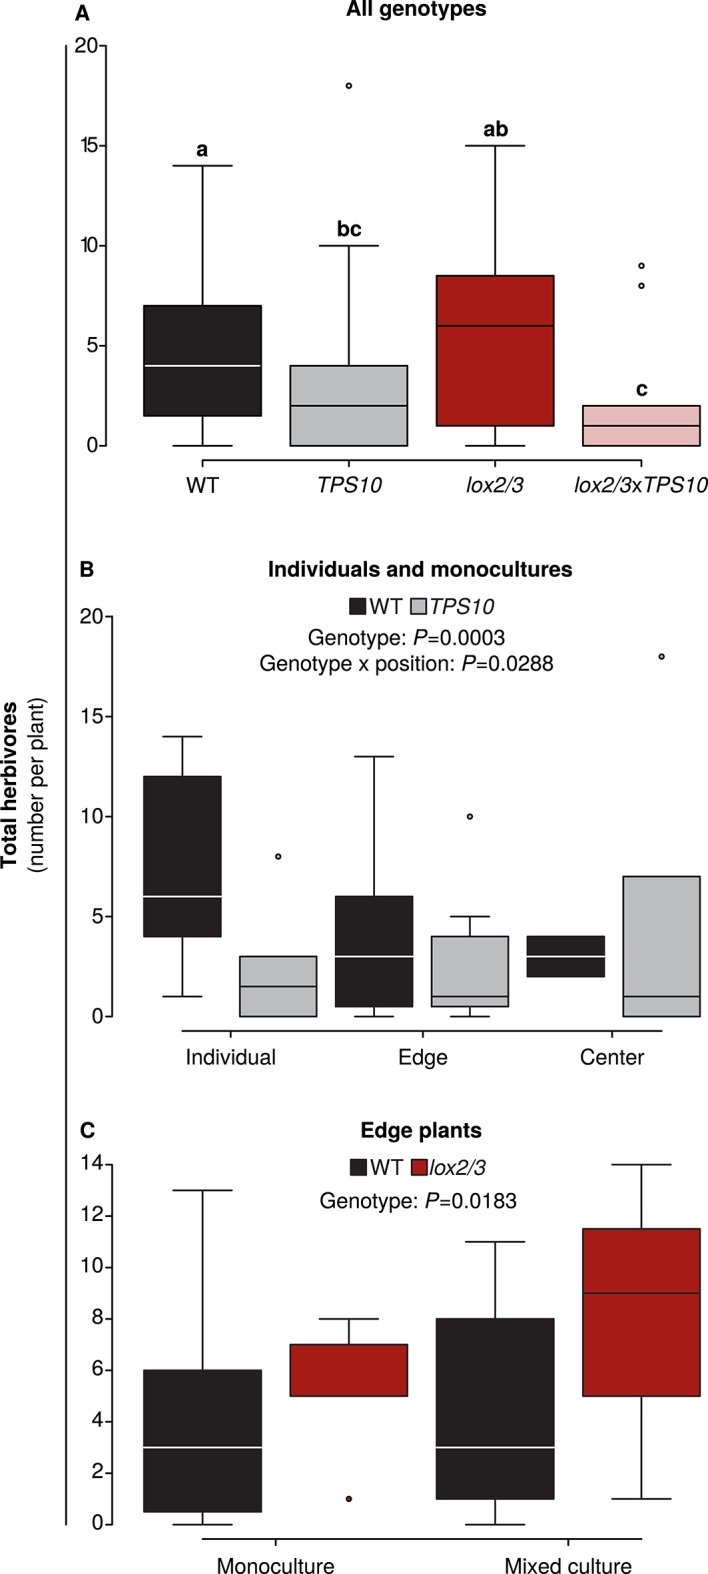
Foliar herbivore abundance is determined by TPS10 expression, lox2/3 expression, and plant position.Data were collected on June 26th in season two, when herbivores and predators were more abundant (see Figure 5). Black denotes WT, grey TPS10, red lox2/3, and pink lox2/3xTPS10 plants. Counts for individual herbivores and predators are given in Figure 6—source data 1, 2. (A) Herbivore counts on focal plants of each genotype revealed fewer herbivores present on plants expressing TPS10 (n given in Figure 6—source data 1). a,b Different letters indicate significant differences (corrected p<0.05) between genotypes in Tukey contrasts following significant differences in a generalized linear mixed-effects model (see Appendix 3). (B) For WT and TPS10 individuals or plants in monocultures (n given in Figure 6—source data 2), there was a significant effect (p<0.05) of plant genotype (z = −3.662, p=0.0003) and an interaction of genotype with position (TPS10 by center vs individual position, z = 2.186, p=0.0288, generalized linear mixed-effects model in Appendix 3). (C) The presence of a TPS10-expressing neighbor in mixed populations did not significantly affect herbivore abundance on WT or lox2/3 edge plants, but there was a significant difference between WT and lox2/3 genotypes at the edges of populations (n given in Figure 6—source data 2, z = 2.358, p=0.0183, generalized linear model in Appendix 3).DOI:
http://dx.doi.org/10.7554/eLife.04490.01610.7554/eLife.04490.017Figure 6—source data 2.Total and median numbers of herbivores counted on focal plants of different genotypes on June 26th in season two, broken down into different population types and plant locations for WT and TPS10 plants.Replicate numbers of lox2/3 and lox2/3xTPS10 plants were not sufficient for this analysis (n ≤ 3 per population type and position).DOI:
http://dx.doi.org/10.7554/eLife.04490.01710.7554/eLife.04490.018Figure 6—source data 1.Total and median numbers of herbivores and predators counted on focal plants of different genotypes on June 26th in season two.